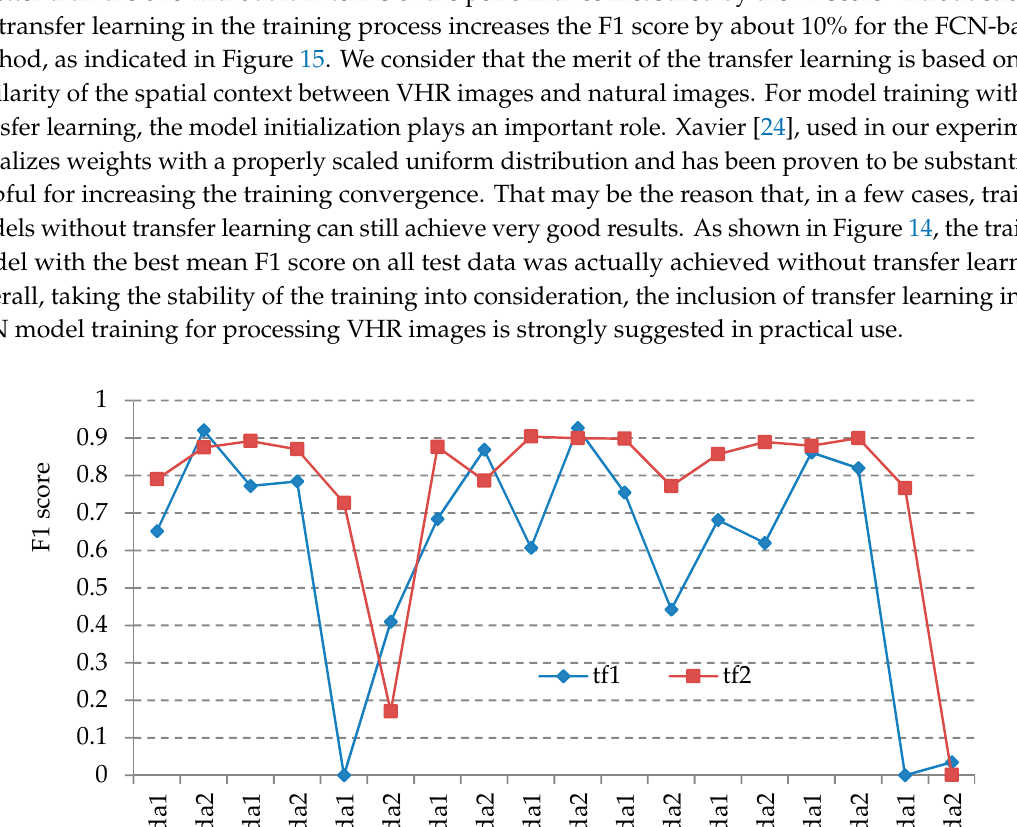
Figure 13. Average F1 scores of 12 models for 10 test areas with different training data.